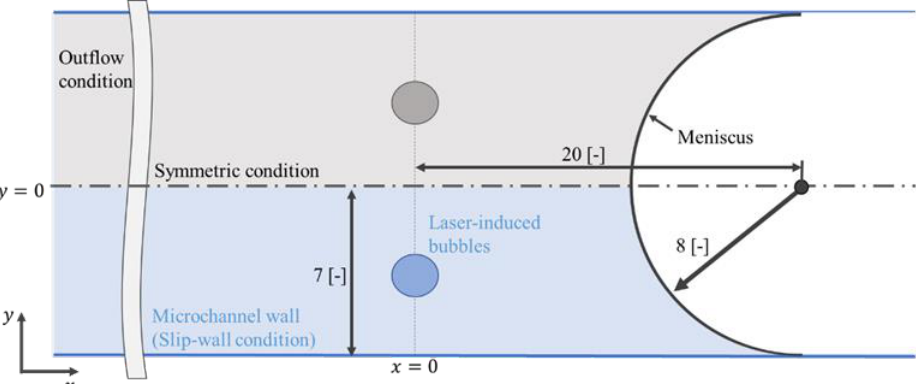
Figure 2. Simulation settings for the microchannel with meniscus (w-meniscus setting). This figure shows the setting for the case of two